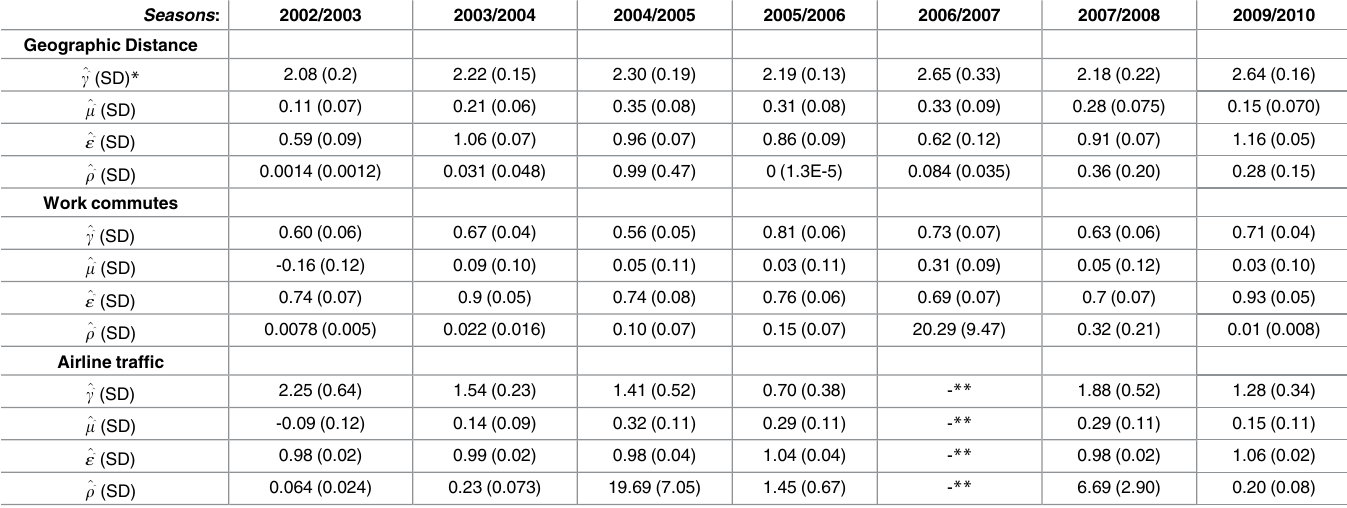
(cid:16) j H ; m ; g ; ε ; r j t j